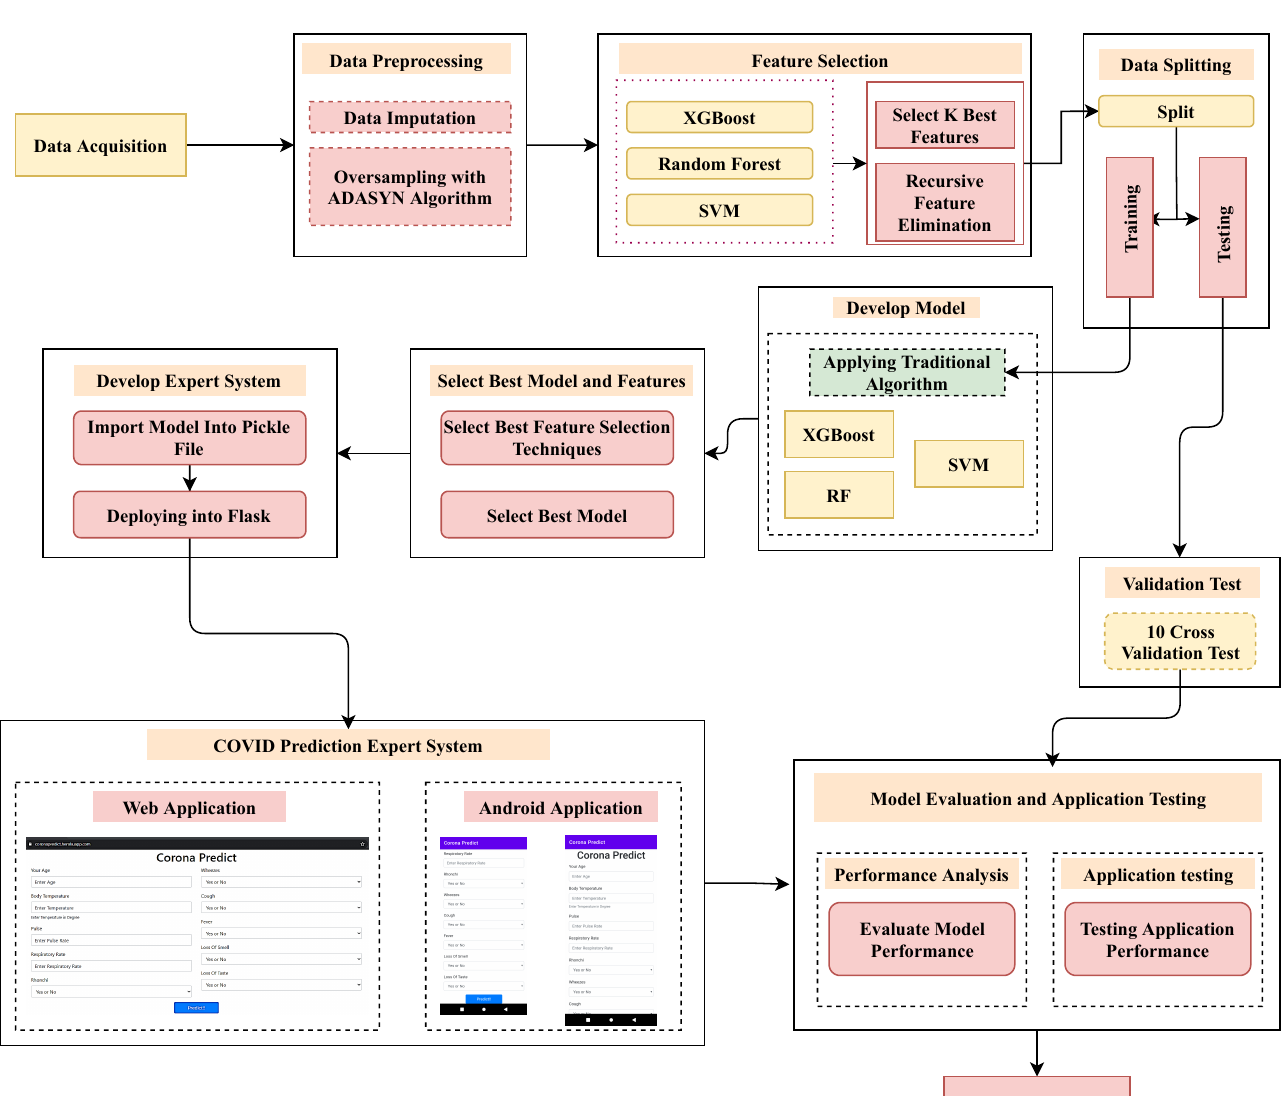
Figure 1. The recommended workflow for the identification of COVID-19 in conjunction with the proposed user